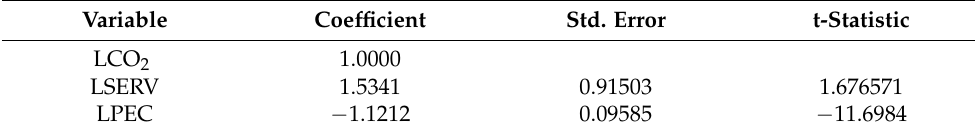
Table A5. Long-run equilibrium.